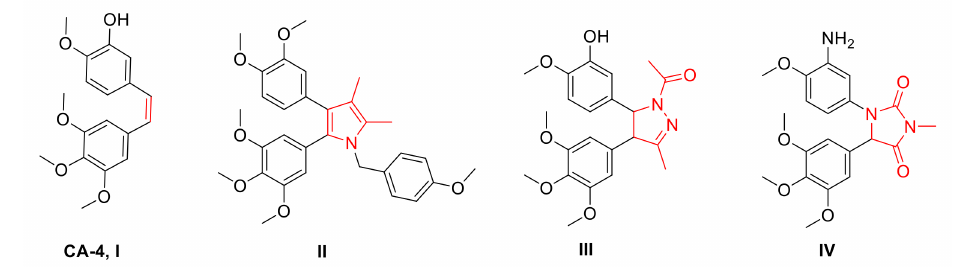
Figure 1. Chemical structure of CA-4, ( I ) and its analogs ( II – IV